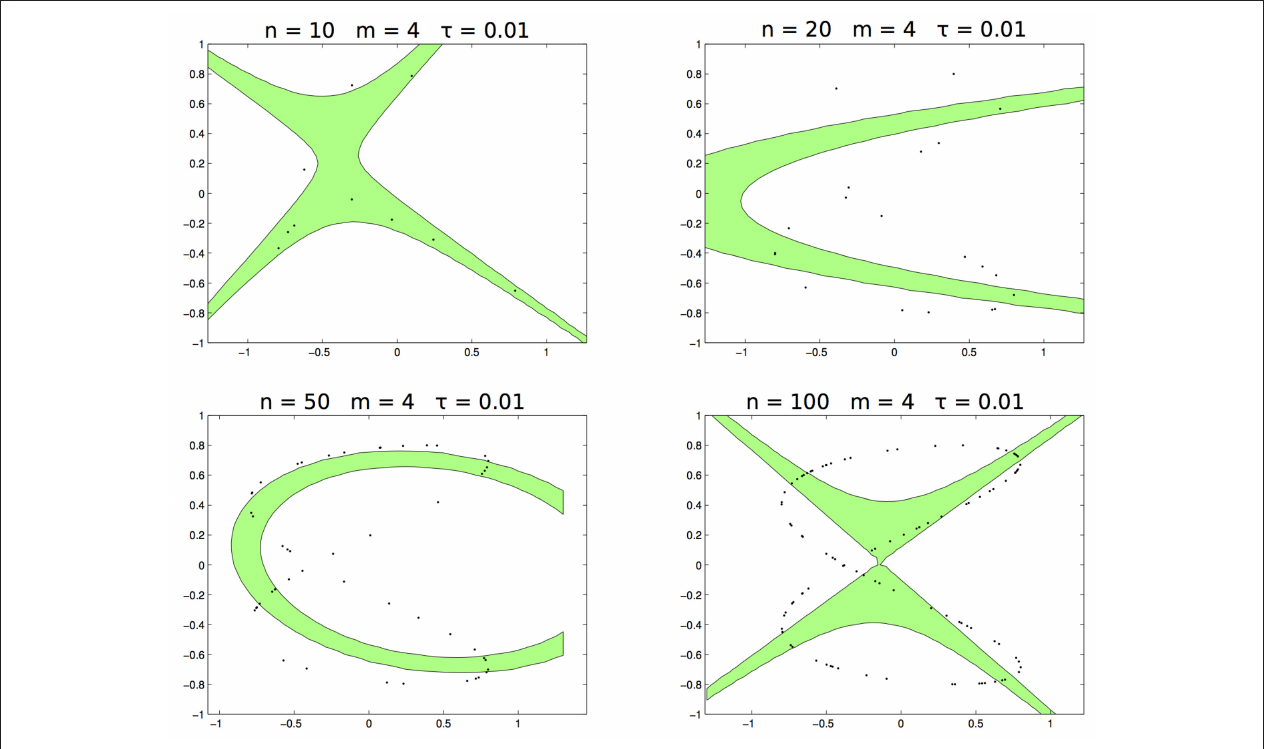
FIGURE 4 | The set ˆ C 4,0.01 n with n respectively 10,20,50,100